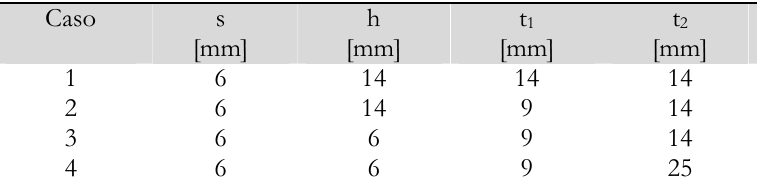
Tabella 2: Valori dei parametri geometrici di Fig.